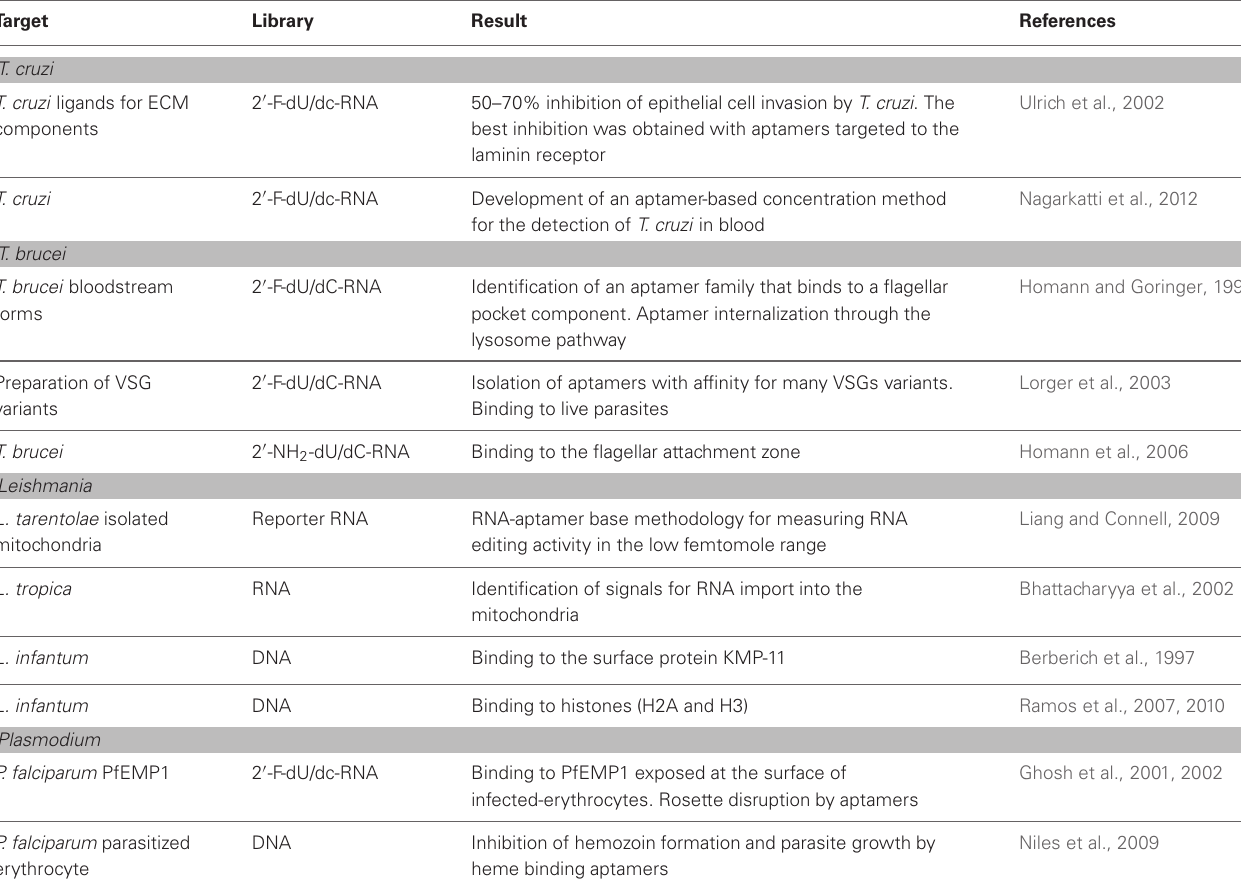
Table 6 | Summary of the applications of aptamers on protozoan parasite